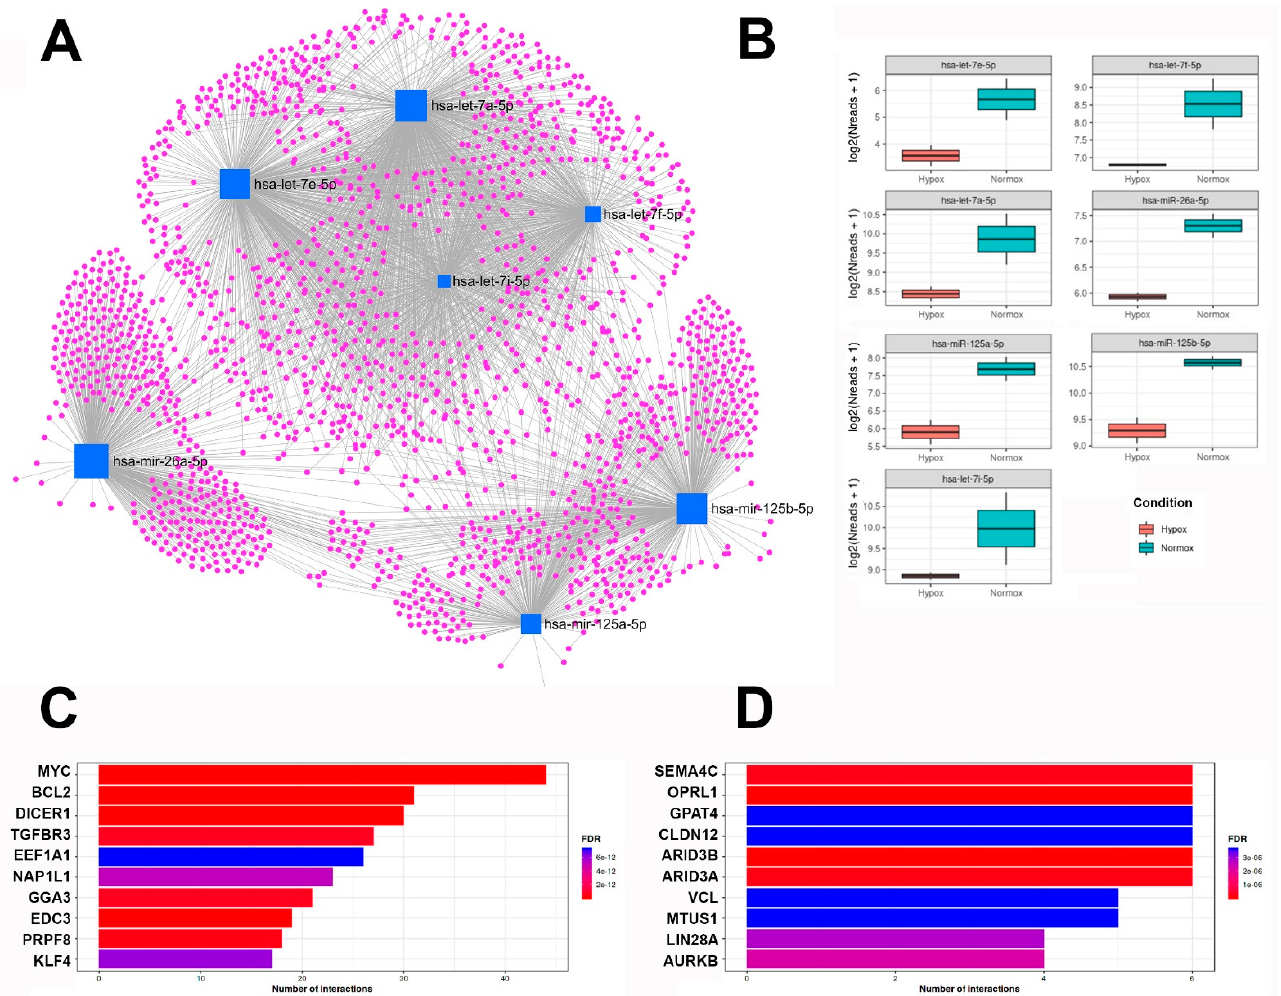
Figure 6. Network visualization and Boxplots of seven significantly regulated miRs. ( A ) Network visualization: miR (blue squares) and the potentially interacting gene-network (magenta dots) created with miRNet2.0. ( B ) Boxplot of regulated miRs ( y -axis: expression level) created with ggplot2 in R. All seven significantly regulated miRs were downregulated in EVs after hypoxic pretreatment. ( C ) miR-target enrichment with all 169 miR using miRTarBase (in MIENTURNET). Bars show the ten genes ( y axis: gene symbol) with the highest number of interactions. ( D ) miR-target enrichment using the seven significantly regulated miR (miRTarBase in MIENTURNET). Bars show the ten genes (y axis: gene symbol) with the highest number of interactions.